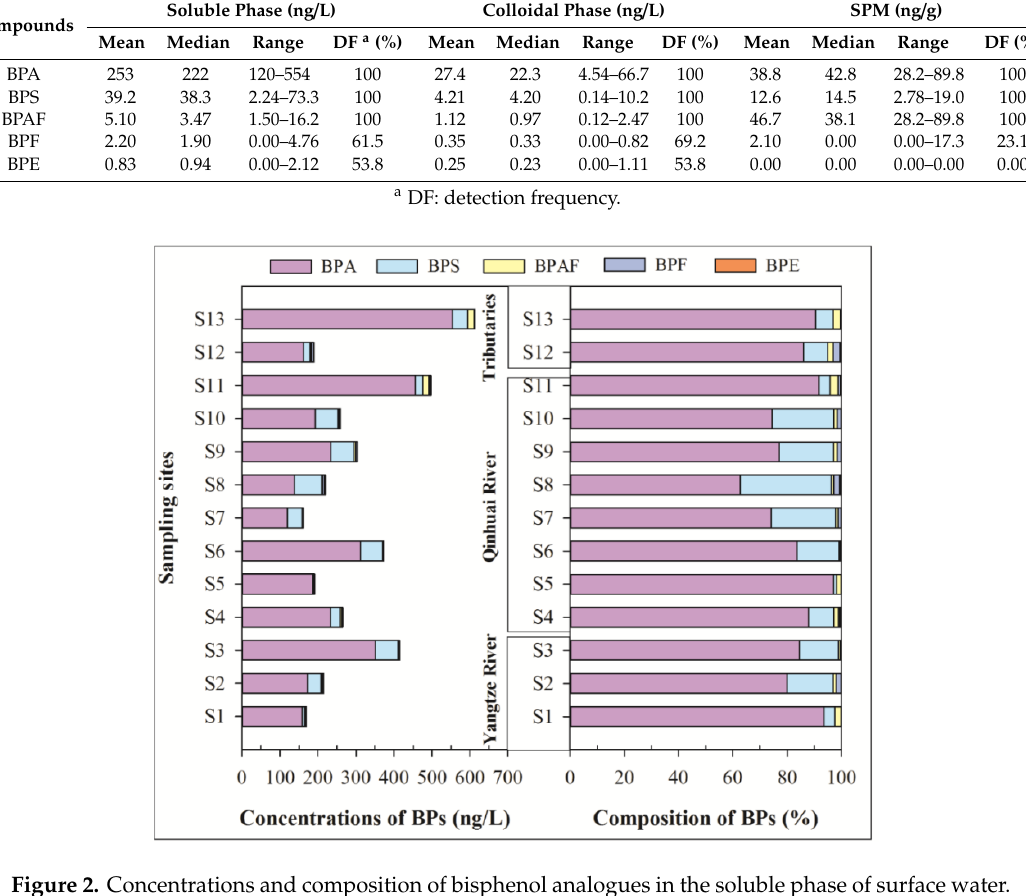
Figure 2. Concentrations and composition of bisphenol analogues in the soluble phase of surface water.